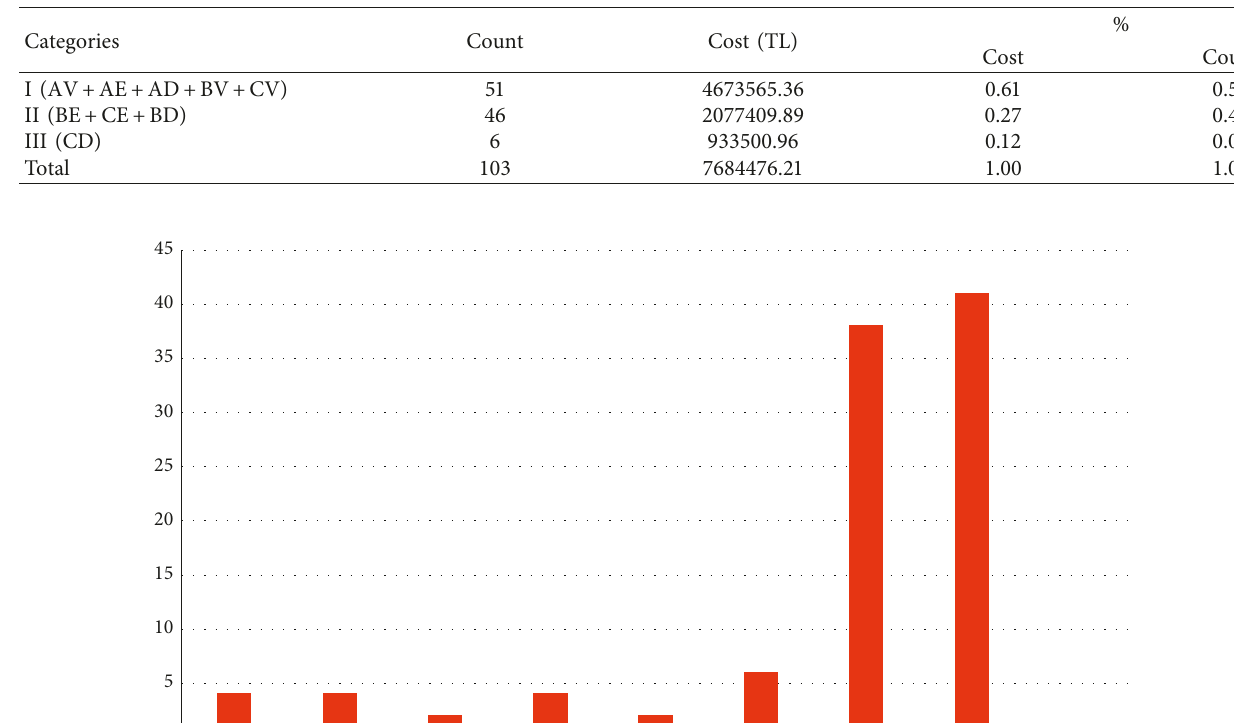
Table 5: Integrated ABC-VED results.